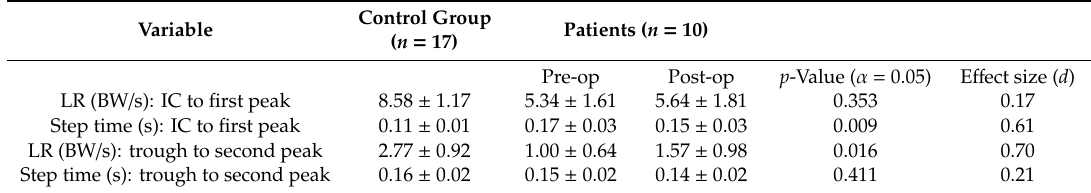
Table 3. Loading rate (BW / s) and time to peak (s) during stance